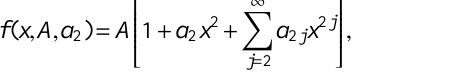
Figure 4. Profile of dimentionless potential field f ( x ) with rotation. The values of parameters are the same as the non-rotational case, in the Taylor 2 1 . except the Coriolis parameter Ω= 0 . 23s −